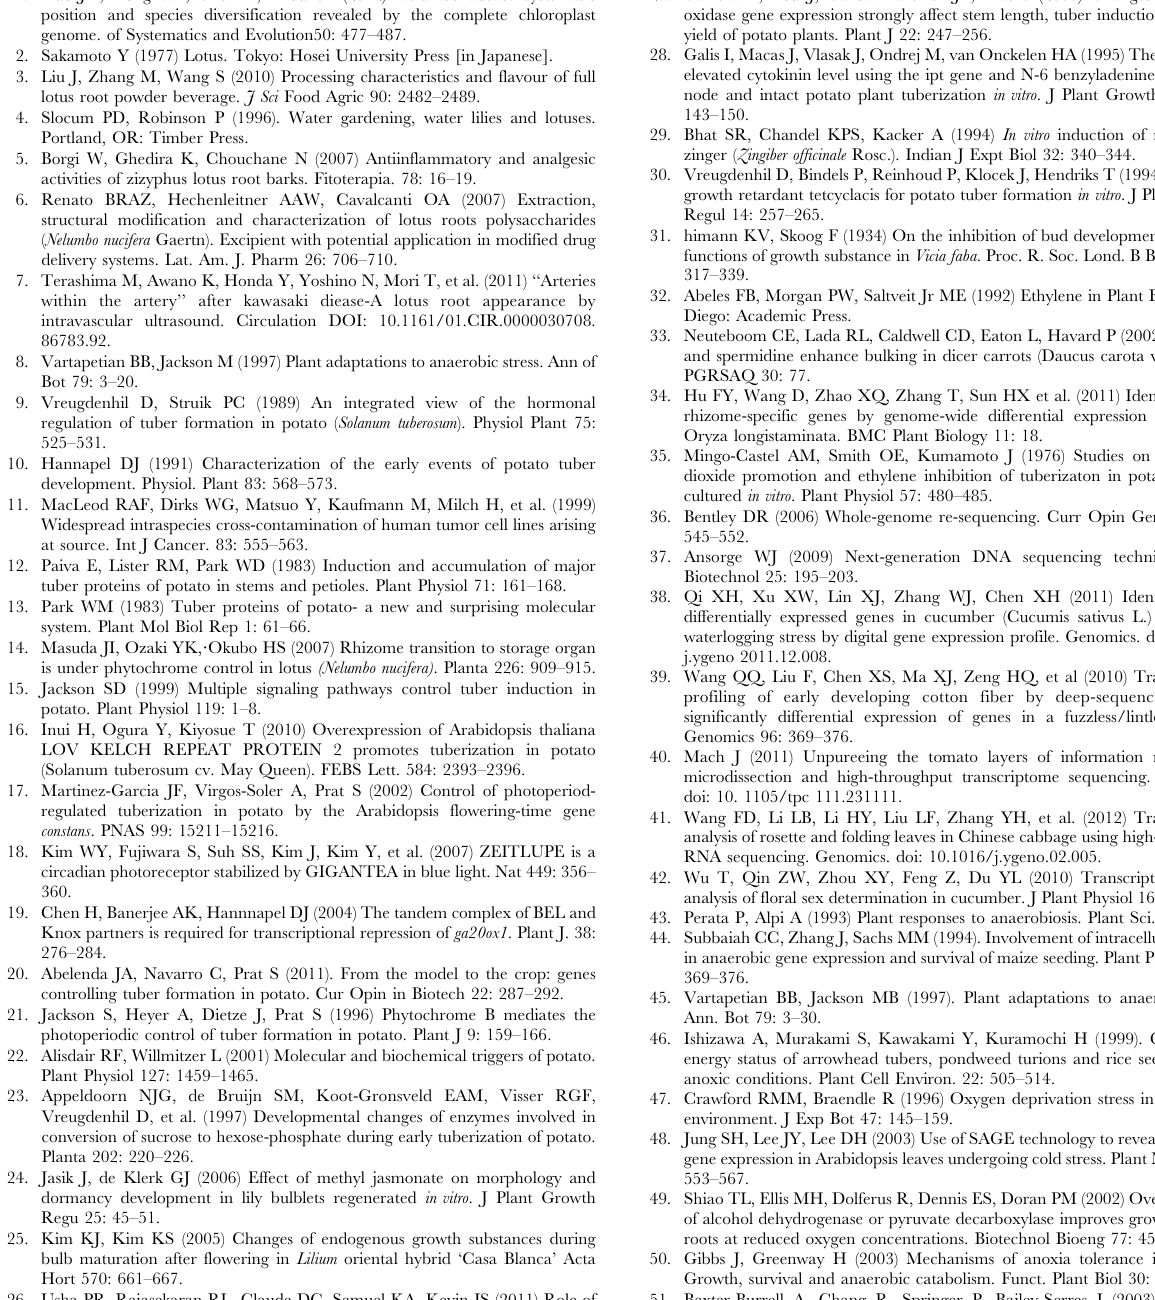
Figure S4 Expression profiles of 18 genes at stolon stage, initial swelling stage and middle swelling stage in rhizome lotus, flower lotus, and seed lotus. Table S1 Genes were found to enhance their expression in L1/ L2, L2/L3, and L3/L4 libraries. These genes were listed in descending order according to alteration of expression during rhizome